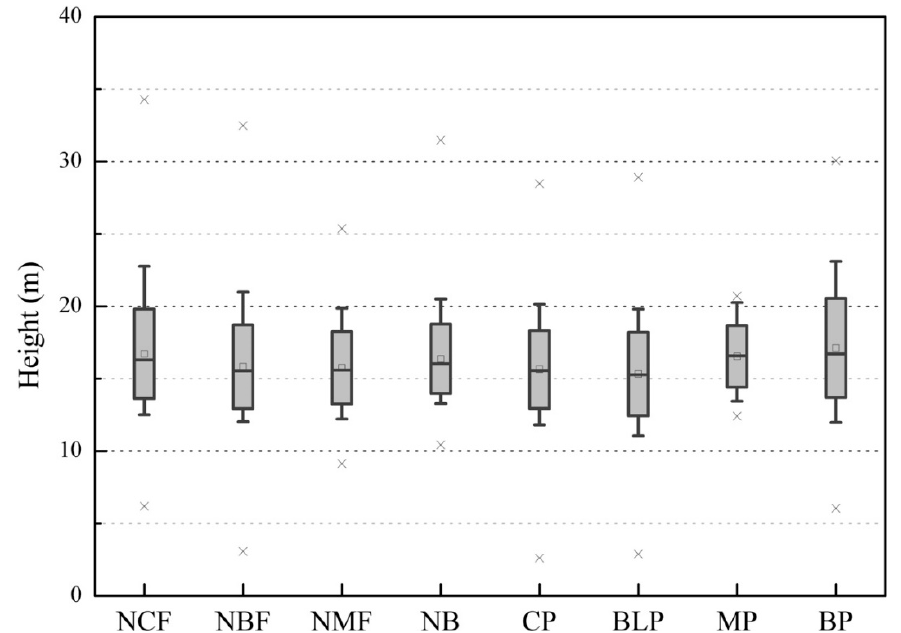
Figure 8. Distribution of forest heights from remote sensing data between different forest types in natural forests and plantations. Box represents data within the range of median ± standard deviation (SD), the square represents the mean, the dash is the whisker within 5%~95%, and the cross represents minimum and maximum values.